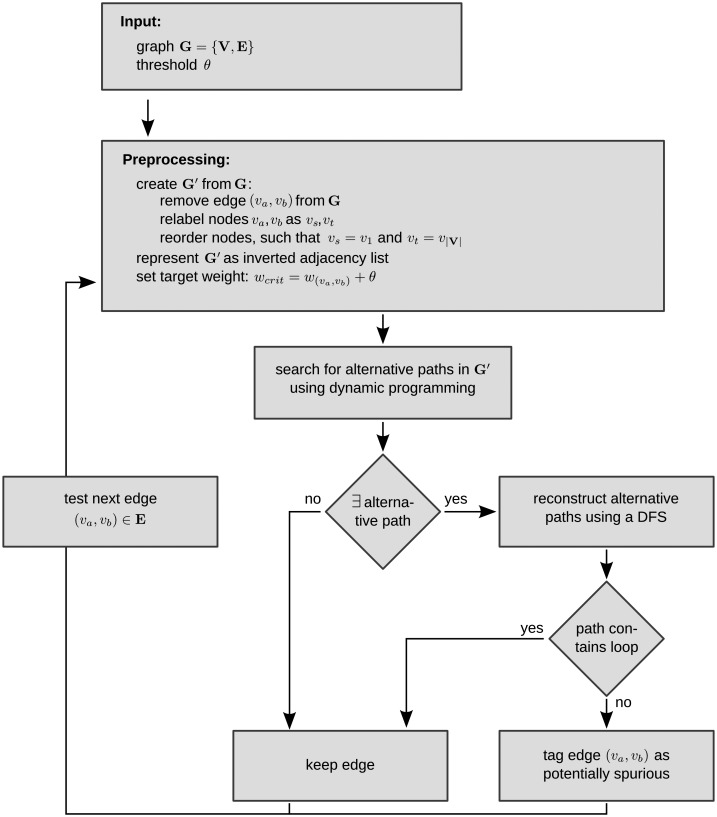
Overview of the proposed algorithm.The algorithm expects a weighted and directed graph G = {V,E} and a threshold θ as input. In a preprocessing step, the algorithm creates graph G′ from input G, as an input for the dynamic programming algorithm, by removing edge (v
a, v
b) and by relabeling and reordering nodes. Then, in the next step, alternative paths for (v
a, v
b), are searched through dynamic programming (see also main text). If at least one alternative path is found, paths are reconstructed using a depth first search (DFS, [27]) to ensure that alternative paths do not contain loops. If an alternative path contains no loops, the currently investigated edge (v
a, v
b) is tagged as potentially spurious. If no alternative edge is found, (v
a, v
b) is considered non-spurious. The algorithm then enters the next iteration, in which the next edge (v
a, v
b) ∈ E is investigated for alternative paths.